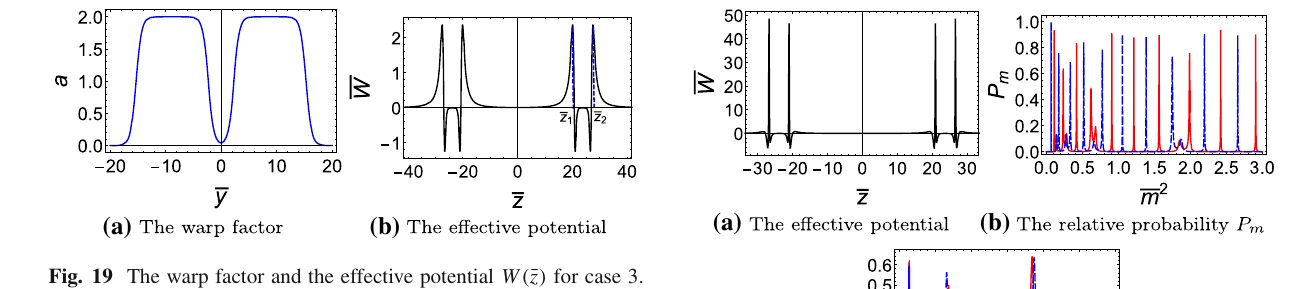
shown in Figs. 22, 24, and 26 for corresponding ¯ α